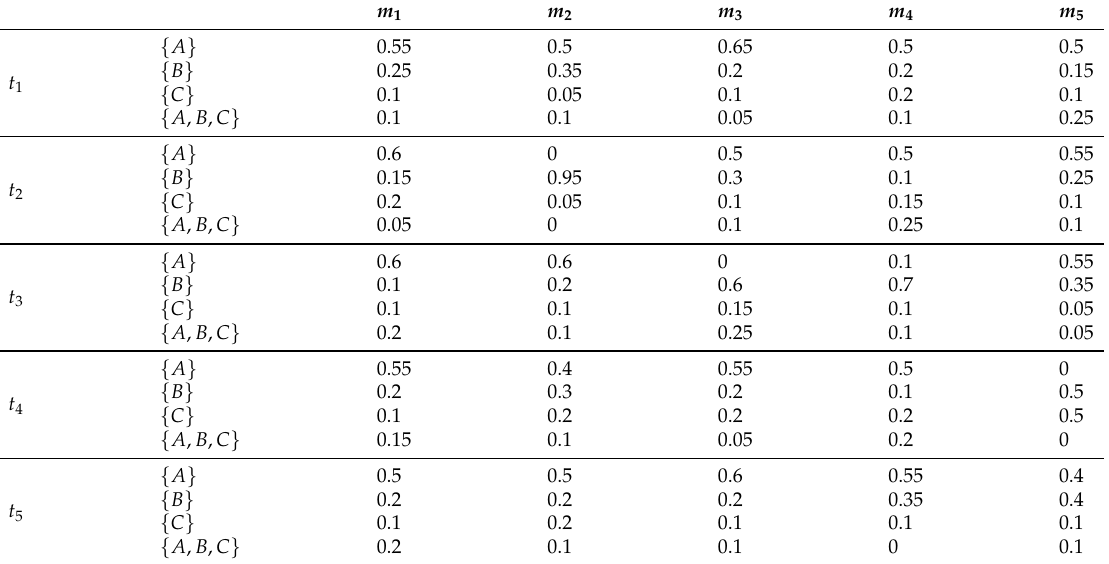
Table 1. Basic Probability Assignments generated at different moments by the five